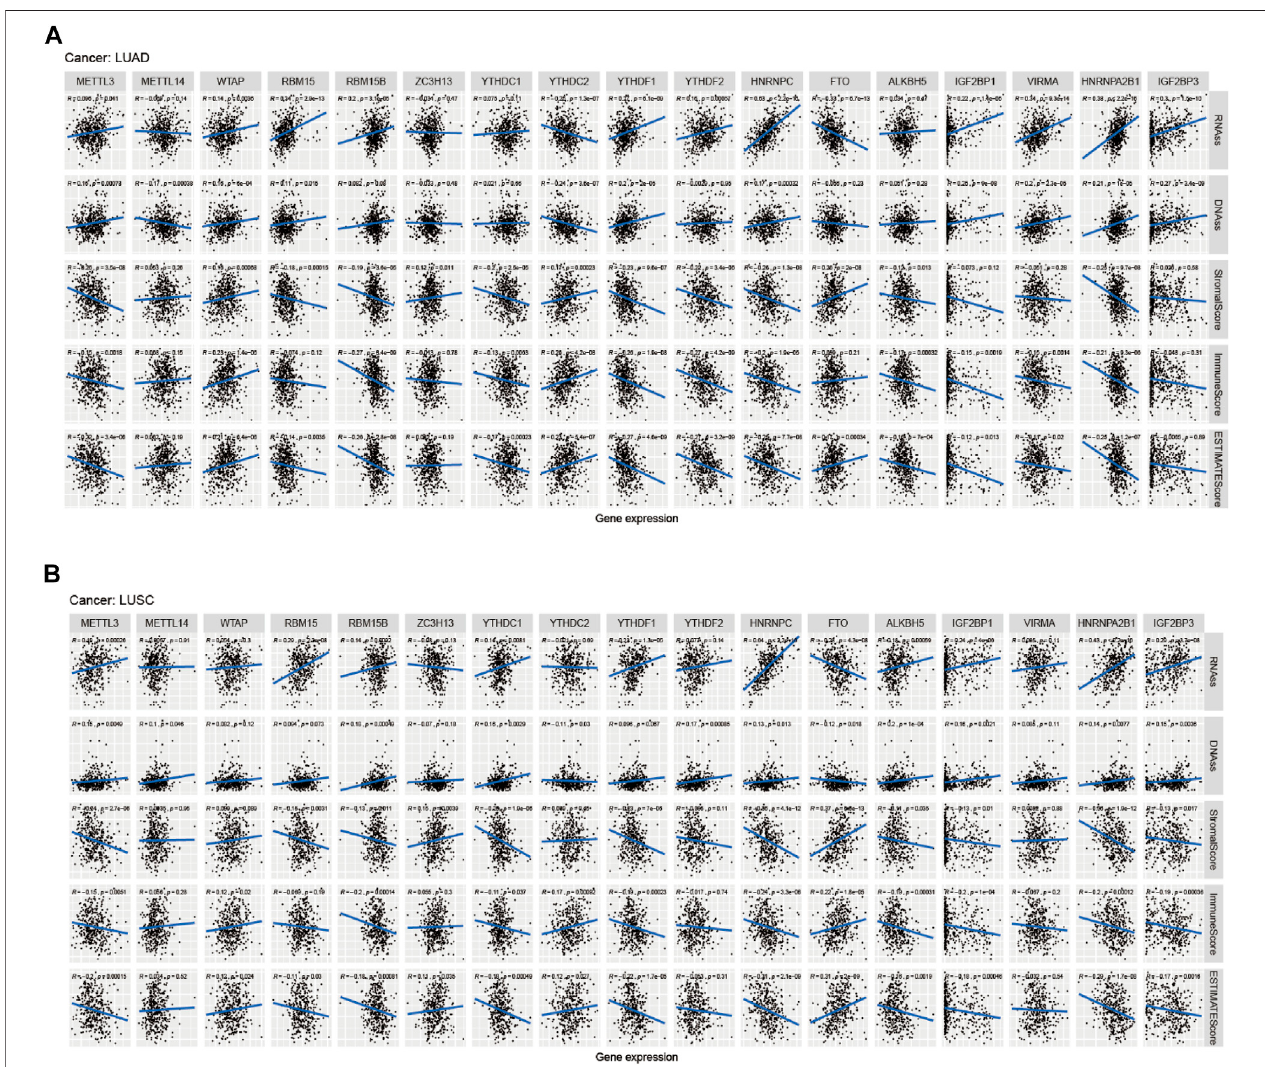
FIGURE 9 | Correlation analysis of m6A regulators and LUAD, LUSC microenvironment, and stem cell scores. (A – B) The correlation relationship between m6A methylation regulators expression and LUAD, LUSC stem cell score, LUAD, and LUSC immune microenvironment.